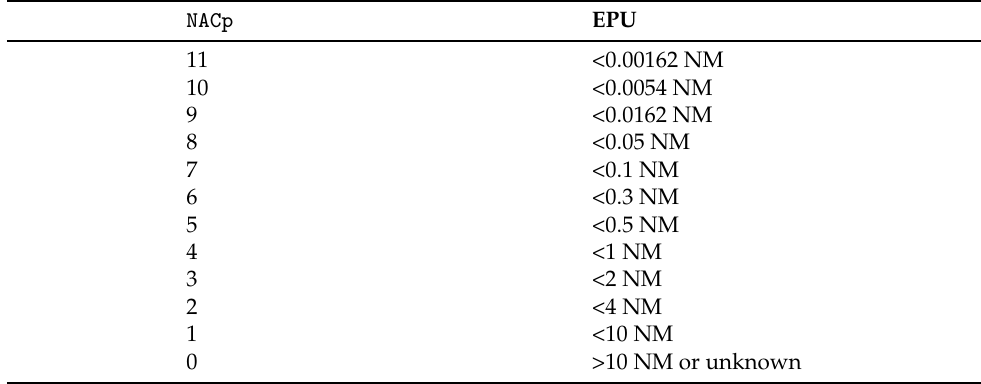
Table 1. NACp and corresponding EPU values. From